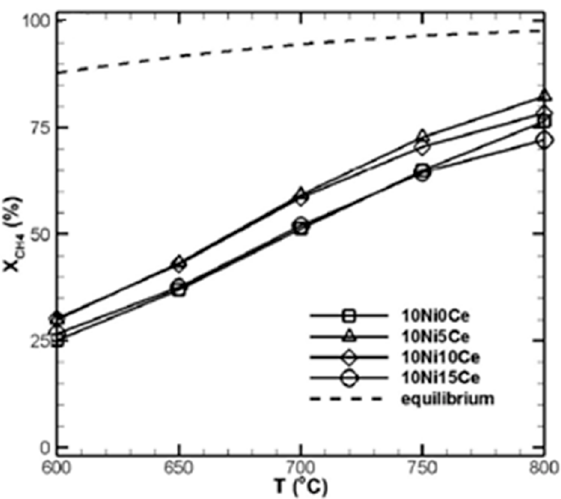
Figure 4. CH 4 conversion obtained from the 10Ni15Ce catalyst is lower than that from the 10Ni10Ce and 10Ni5Ce catalysts. Figure republished with permission from [73]. Copyright Elsevier, 2019. Swirk et al. [87] studied DRM double-layered hydroxides modified with cerium (co- precipitation method) and with yttrium prepared by the incipient wetness impregnation method with 0.2, 0.4 and 0.6 wt%. Ni reducibility decreased, basicity increased, Ni disper- sion enhanced and smaller Ni crystallites were observed with the promotion of both Ce and Y, as compared with a hydrotalcites catalyst due to the formation of a yttria-doped ceria (YDC) phase. Highlighted in the studies was the modification of the smallest loading of yttrium (0.2 wt%) which led to an increase in both CO 2 and CH 4 conversions for 5 h. Zhang et al. [88] investigated the effect of adding Zr dopants into the ceria support, Ni/CeZrO 2 , on the DRM reaction performance and revealed that the conversion, reaction rate and H 2 selectivity substantially increased with the addition of a Zr dopant. A larger Ce 3+ substance was noticed in the mixed-oxide support upon the reaction with pure CH 4 or during DRM, when doping the Zr into the ceria support implied a higher reducibility of the mixed-oxide support. Moreover, Zr prevented Ni migration from the surface into ceria forming a Ce 1 − x Ni x O 2 − y solid solution which maintained the active NiO on the Ni/CeZrO 2 surface. Hassani Rad SJ, et al. [89] prepared Ni/Al 2 O 3 -CeO 2 and Ni/Al 2 O 3 -MgO nanocatalysts using the impregnation and sol-gel methods. The sol-gel method produced a better per- formance compared to the impregnation method as it provides a much higher surface area, a better dispersion of metals, a more homogenous morphology and a smaller nano- particle size leading to modified adsorption properties. Among all, the sol-gel method synthesized with the ceria promoter catalyst and the Ni/Al 2 O 3 -CeO 2 nanocatalyst emerged as the best choice as it exhibited a H2/CO ratio of 1 and a H2 yield of 94% at 850 °C. Farooqi [72] compared the performances of three catalysts, namely Ni/Al 2 O 3 , Ni/Al 2 O 3 -CeO 2 and Ni/Al 2 O 3 -La 2 O 3 which were prepared by the sol-gel method. The cata- lyst with the addition of CeO 2 on the support showed the highest and most stable conver- sion due to the fact that it enhanced dispersion, increased the active metal content on the catalyst surface and improved the reducibility and basicity of the catalyst. Price et al. [90] highlighted that encapsulation techniques with incorporations of 8 wt% Ni/ZnO cores in silica (SiO 2 ) can lead to advantageous conversions of CO 2 and CH 4 at high temperatures compared to uncoated traditional catalytic materials: Ni/CeO 2 and Ni/Al 2 O 3 . Encapsulating a catalytic core increases the surface area and reaction kinetics which results in a high level of reactant conversion. Das et al. [91] developed a novel core-shell structured Ni-SiO 2 @ CeO 2 catalyst with Ni nanoparticles sandwiched between SiO 2 and CeO 2 layers as shown in Figure 5, applied for the dry reforming of bio-gas (CH 4 /CO 2 = 1.5) at low temperatures (600 °C). Ni-